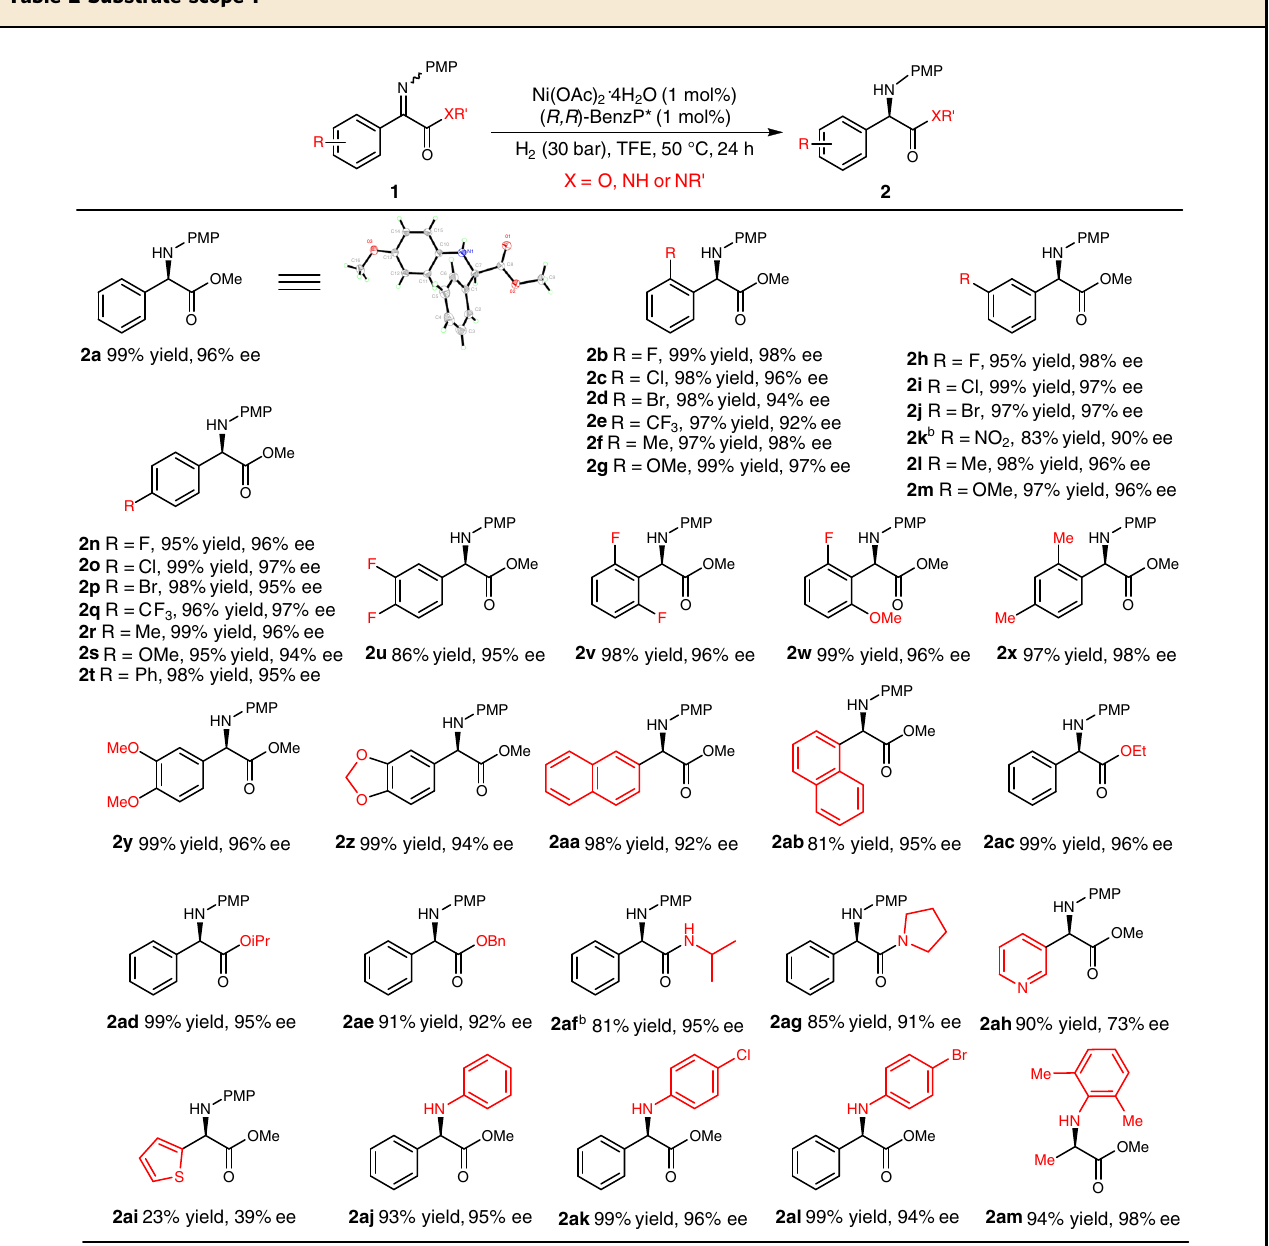
Table 2 Substrate scope a